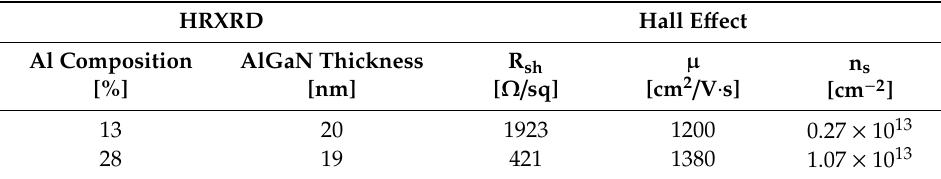
Table 1. Structural parameters, sheet resistance, 2-dimensional electron gas (2DEG) densities, and electron mobility in Al x Ga x − 1 N / GaN HEMTs measured by HRXRD and the Hall e ff ect.